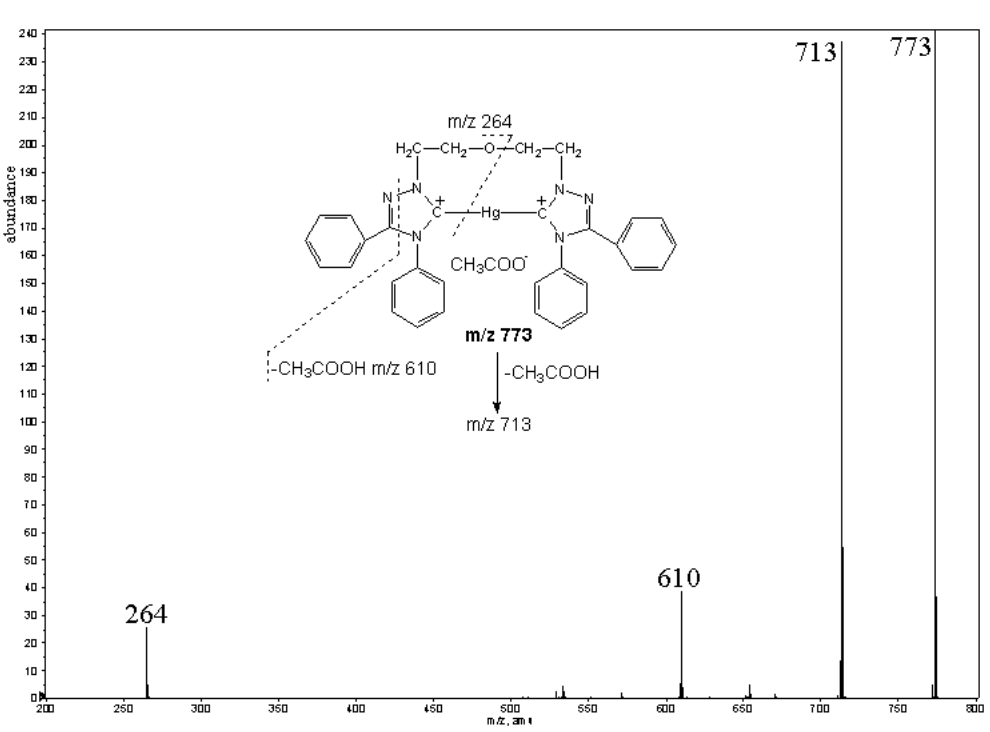
Fig. 5 MS/MS spectrum of [ 6 +HgOOCCH 3 ] + at m/z 773 (collision energy 25 eV) and fragmentation pathway